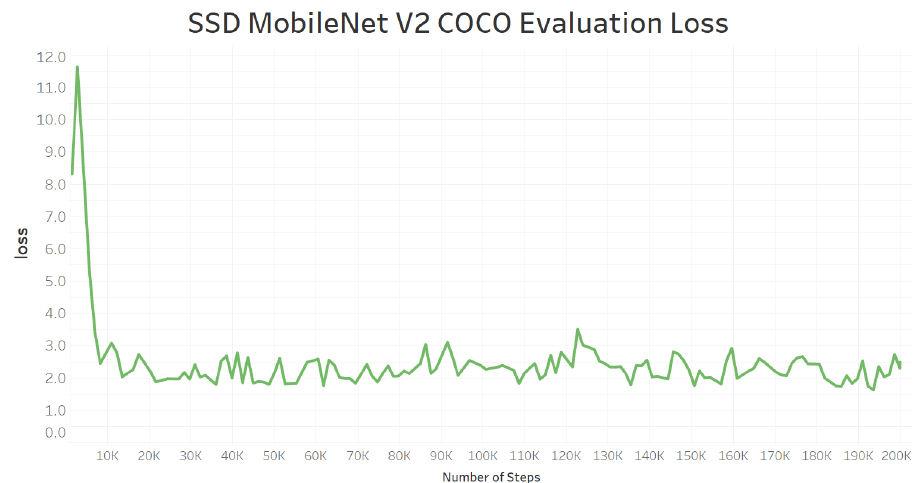
Figure 15. The evaluation loss of SSDV2 by the end of the training is around 1.80. Again, both values being in the neighborhood of each other states no over-fitting in the model.